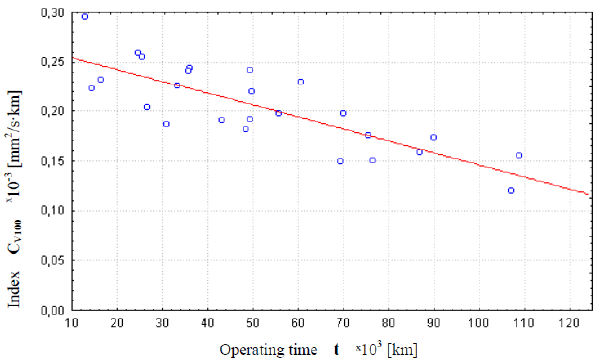
Fig. 2. The course of the kinematic viscosity change intensity index at 100°C C V100 as a function of operating time